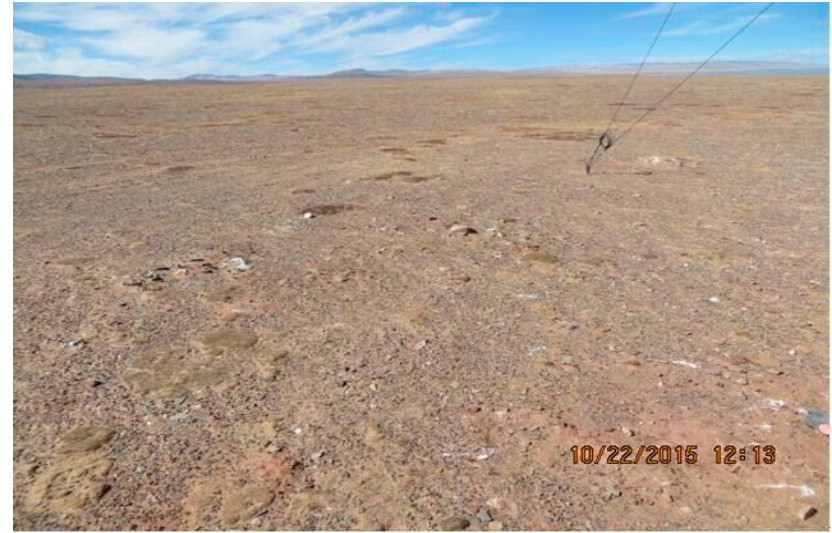
Figure A2. Picture of ZNH underlying surface (taken by Hu guojie).